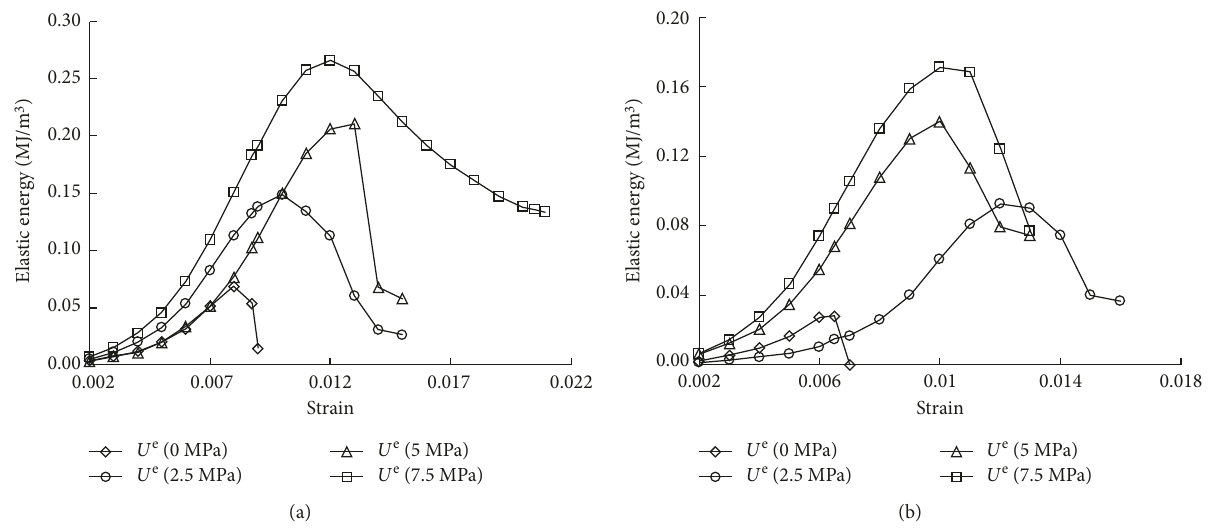
U e U U d p and p and p . (b) p .